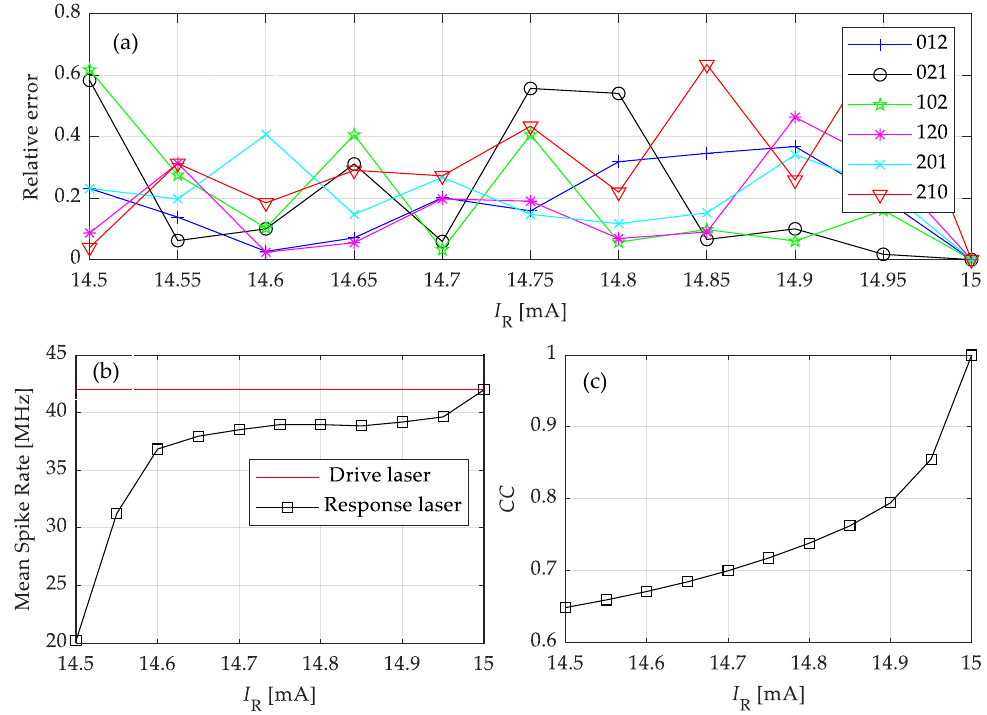
Figure 7. Effect of pump current mismatch on system transmission. ( a ) Event probability error, ( b ) pulse rate, and ( c ) correlation coefficient.